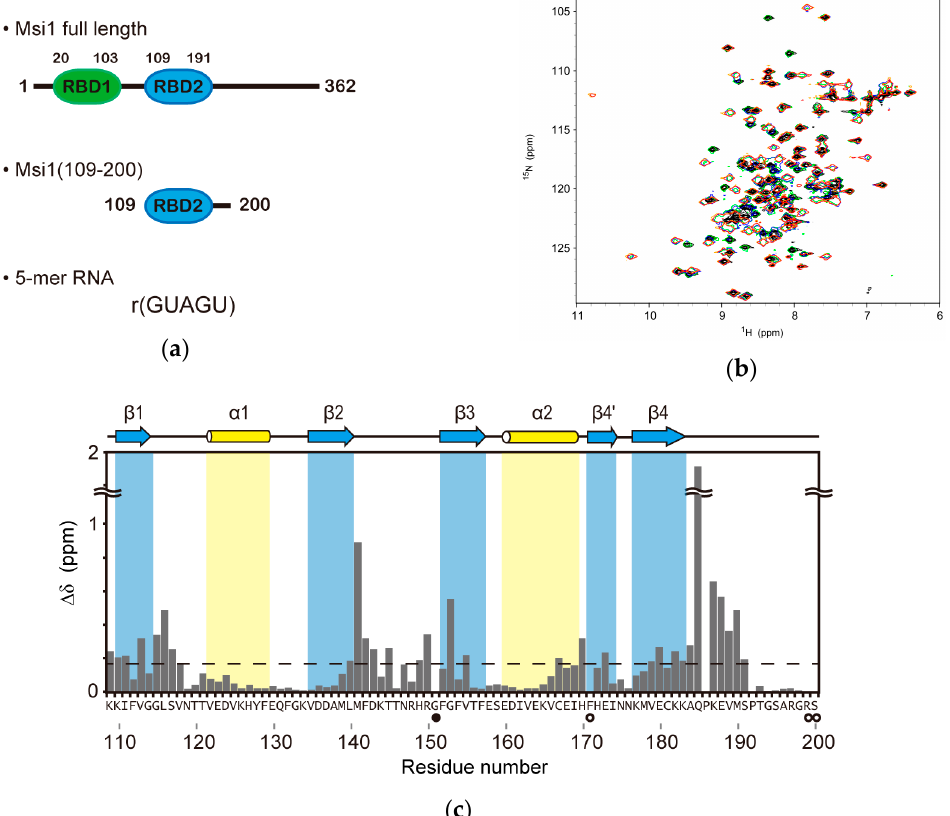
Figure 1. Interaction of r(GUAGU) with Msi1(109–200). ( a ) Domain organization of Msi1 (top), the protein construct used in this study (middle), and 5-mer RNA (bottom) originating from numb mRNA are shown; ( b ) Overlay of the 15 N- 1 H HSQC spectra of Msi1(109–200) (80 μ M) in the absence (black) and presence of r(GUAGU) with Msi1 RBD2:r(GUAGU) ratios of 1:0.25 (green), 1:0.50 (blue), 1:1.00 (yellow), and 1:1.30 (red); ( c ) The chemical shift perturbation, Δδ , was calculated using Δδ = [( Δδ H) 2 + ( Δδ N/6.5) 2 ] 1/2 , where Δδ H and Δδ N are the chemical shift differences between free and complex forms for H N and 15 N, respectively. The dashed line indicates the mean value (0.167 ppm). The secondary structure elements of Msi1(109–200) are shown at the top as blue arrows (strands) and yellow cylinders (helices). The amino acid residues that were not assigned (open circles) or whose 1 H- 15 N resonance vanished upon addition of r(GUAGU) (closed circles) are indicated beneath the amino acid sequence at the bottom.